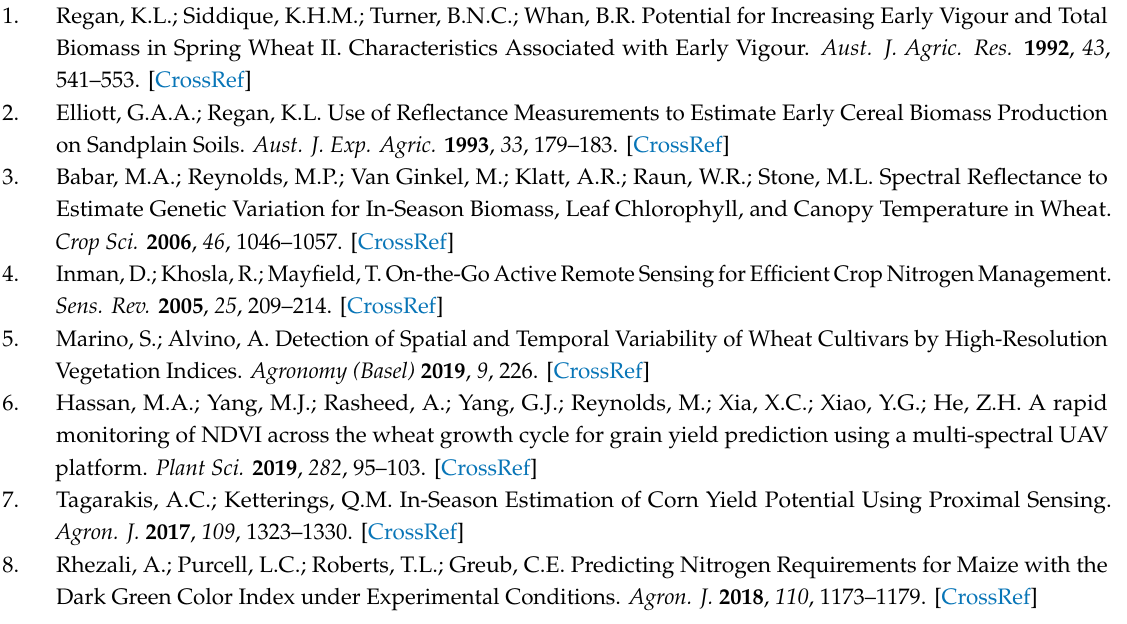
Figure S1: Correlation coe ffi cient (r) between NDVI measurements for 11 dates and grain yield with 72 observations (24 wheat genotypes times 3 replications) under dryland conditions across site year I, Figure S2: Correlation coe ffi cient (r) between NDVI measurements for 11 dates and grain yield with 72 observations (24 wheat genotypes times 3 replications) under irrigated conditions across site year I, Figure S3: Correlation coe ffi cient (r) between NDVI measurements for 14 dates and grain yield with 72 observations (24 wheat genotypes times 3 replications) under dryland conditions across site year II, Figure S4: Correlation coe ffi cient (r) between NDVI measurements for 14 dates and grain yield with 72 observations (24 wheat genotypes times 3 replications) under irrigated conditions across site year II, Figure S5: Experimental setup and genotype arrangement for site year I and site year II, in dryland and irrigation conditions. Outline: Yellow = Dryland; Blue = Irrigated, Filling: Red = replication 1; Yellow = replication 2; Green = replication 3, Letters: A = Above; B = Ankor; C = Arlin; D = Avalanche; E = Baca; F = BillBrown; G = BondCL; H = CO940610; I = Danby; J = Goodstreak; K = Hatcher; L = Jagalene; M = Jagger; N = Keota; O = NuDakota; P = Platte; Q = PrairieRed; R = Prowers99; S = Ripper; T = RonL; U = Sandy; V = Snowmass; W = TAM112; X = Yuma; Y = CO03W054-2. Actual location of the replications relative to each other was modified to accommodate this figure, Table S1: Cluster averages of NDVI showing three classes (low, medium, and high) for each measurement date for site year I and II across irrigation